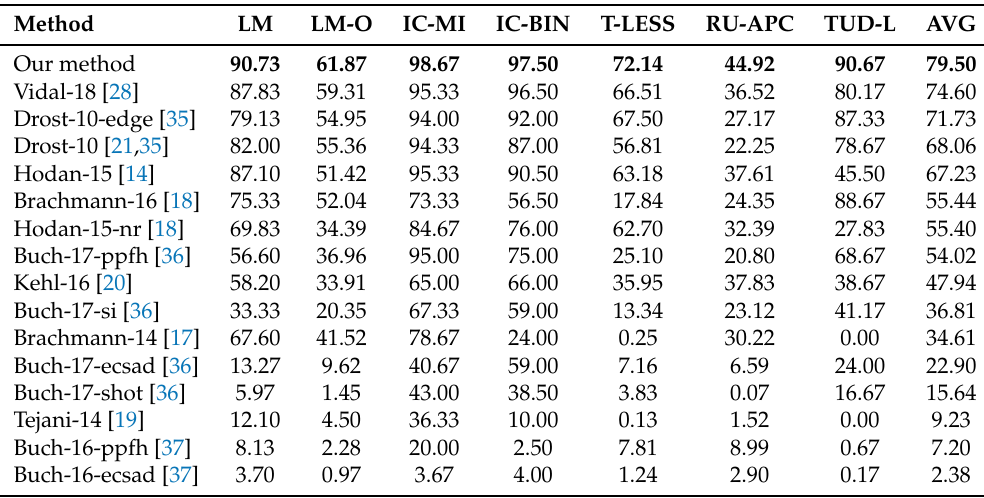
Table 2. Recall scores (%) for the BOP Benchmark [29] using the VSD metric with τ = 20 mm and θ =